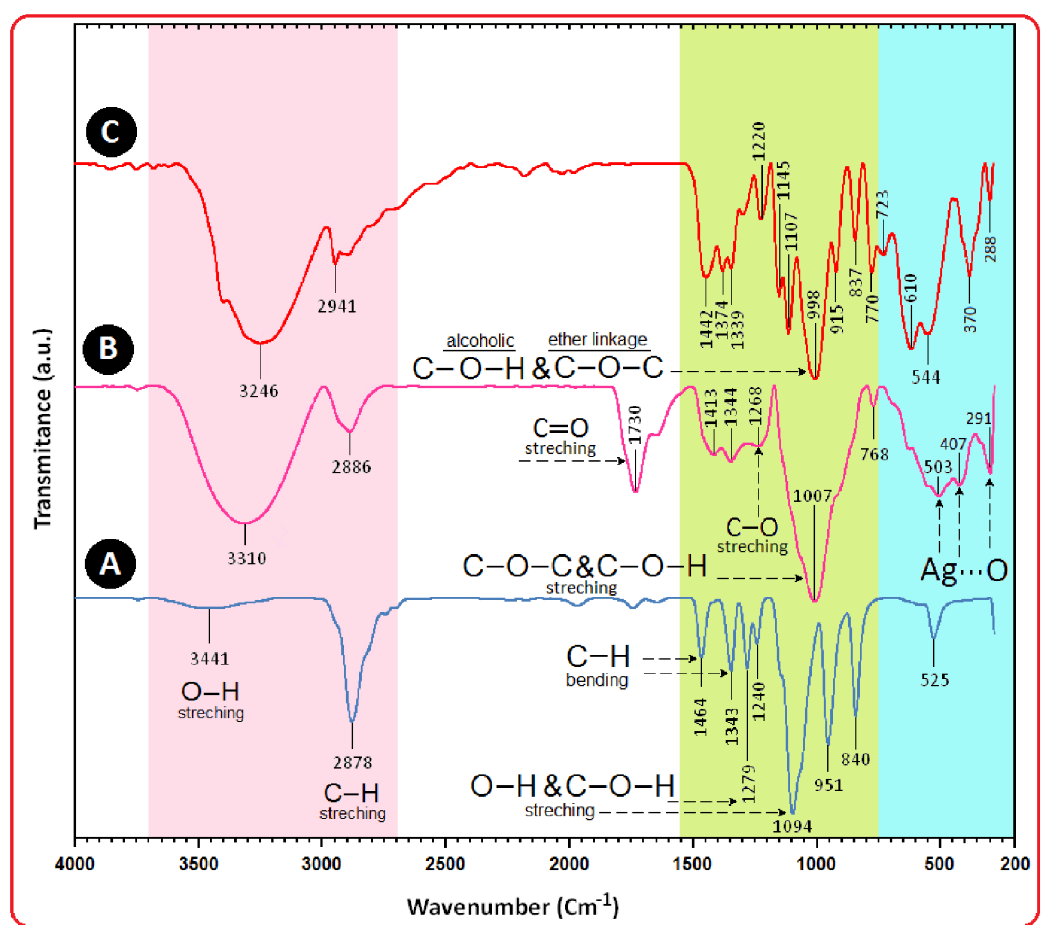
Figure 6. FTIR spectra for PEG ( A ), [Ag(PEG)] for the stirring time of 48 h ( B ) and β -D-glucose ( C ). Figure was adopted from [198]; CC-BY License.